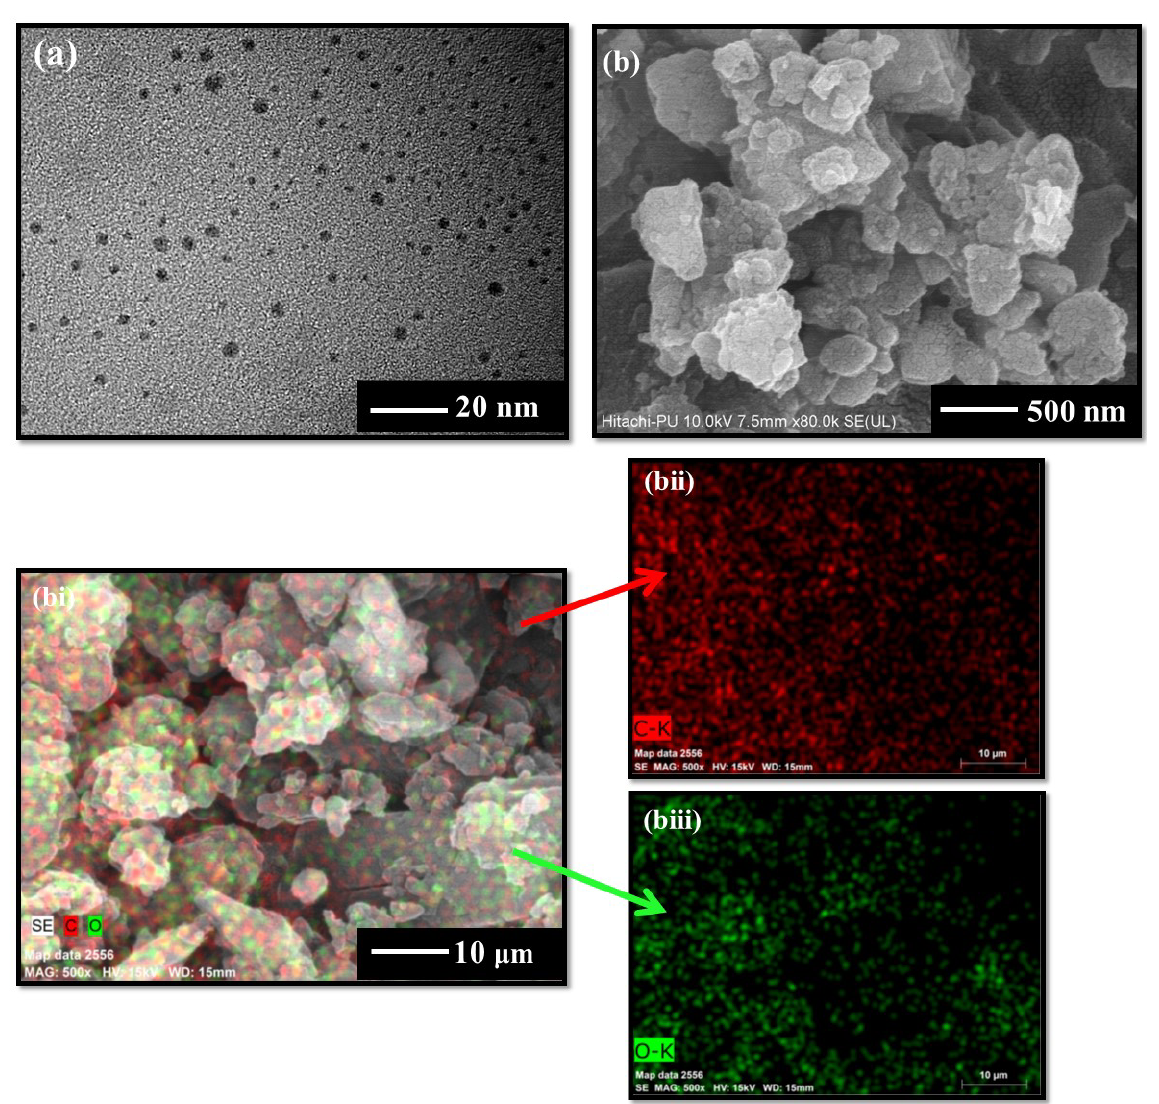
Figure 4. ( a ) HRTEM, ( b ) FESEM images and ( bi – biii ) elemental mapping of